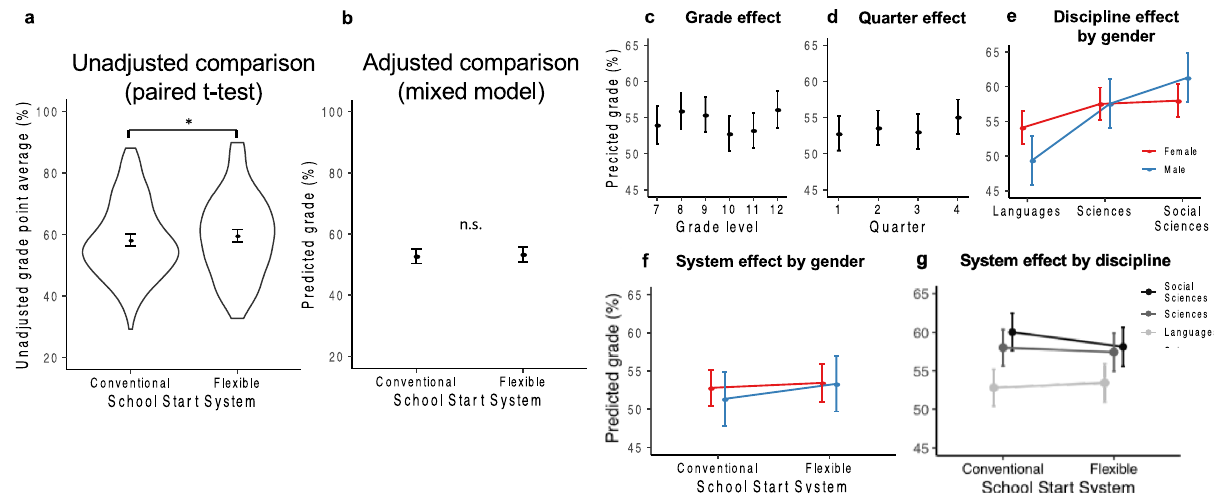
Figure 2. Longitudinal analysis of official quarterly grades—effects of school start system and general predictors. Quarterly grades (0–100%) from 12 academic subjects of 3 disciplines for 4 years i.e., for most students this was 2.5 years before and 1.5 years after the flexible school start was introduced (n = 157 students; 16,724 grades; 107 grades per student on average). (a) Simple, unadjusted comparison of average grades across all disciplines in the conventional and the flexible school start system via paired t-test (n ID = 157). Shown are mean and 95% CI within the raw data distribution (violin plots). The apparent grade improvement in the flexible system was not confirmed in linear mixed models. ( b–g) Visualization of mixed-model-determined influences on grades. Plots show marginal means from Models 1 and 2 (Supplementary Table S1), i.e. the estimated grade and 95% CI for the reference category (female student, class level 10, quarter 1, languages, conventional system). Statistical significance is indicated in (b), results of more complex cases can be found in the text and Supplementary Tables S1 and S2. ( b) Effect of school start system (Model 1). (c) Effect of grade level (Model 1). ( d) Effect of academic quarter (Model 1). ( e) Effect of academic discipline by gender (Model 1). ( f) Effect